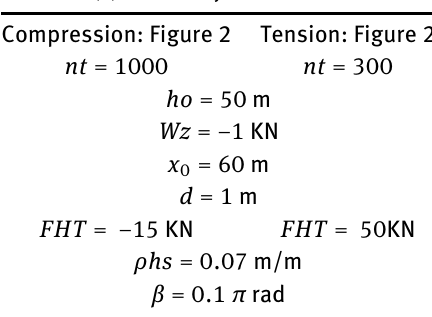
(8) Boundary conditions. Compression: Figure 2 Tension: Figure